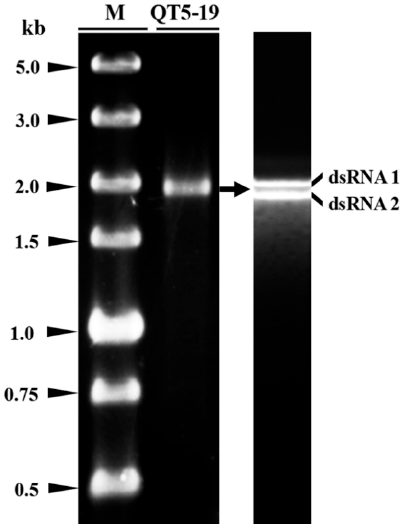
Figure 3. Double-stranded (ds) RNAs in isolate QT5-19 of Botrytis cinerea . The electrophoregram on the left was carried out in a 1.0% agarose gel after 1.5-h electrophoresis under room temperature. The electrophoregram on the right was carried out in a 0.7% agarose gel after 15-h electrophoresis at 4 °C. The dsRNAs were treated with RNase-free DNase I and S1 nuclease before electrophoresis. M = DL5000 dsDNA marker (TaKaRa). Viruses 2019 , 11 , x